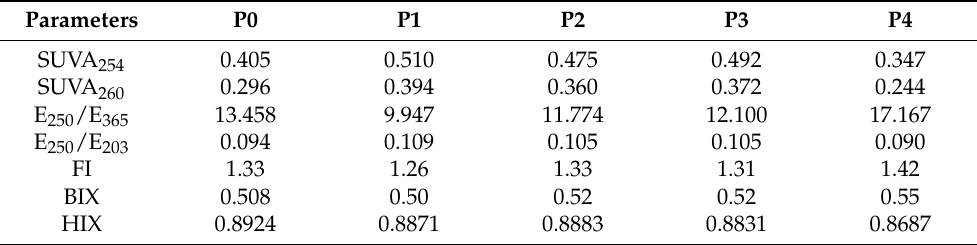
Table 1. UV–Vis absorption and fluorescence spectral parameters of bulk PPFA (P0) and fractionated PPFA